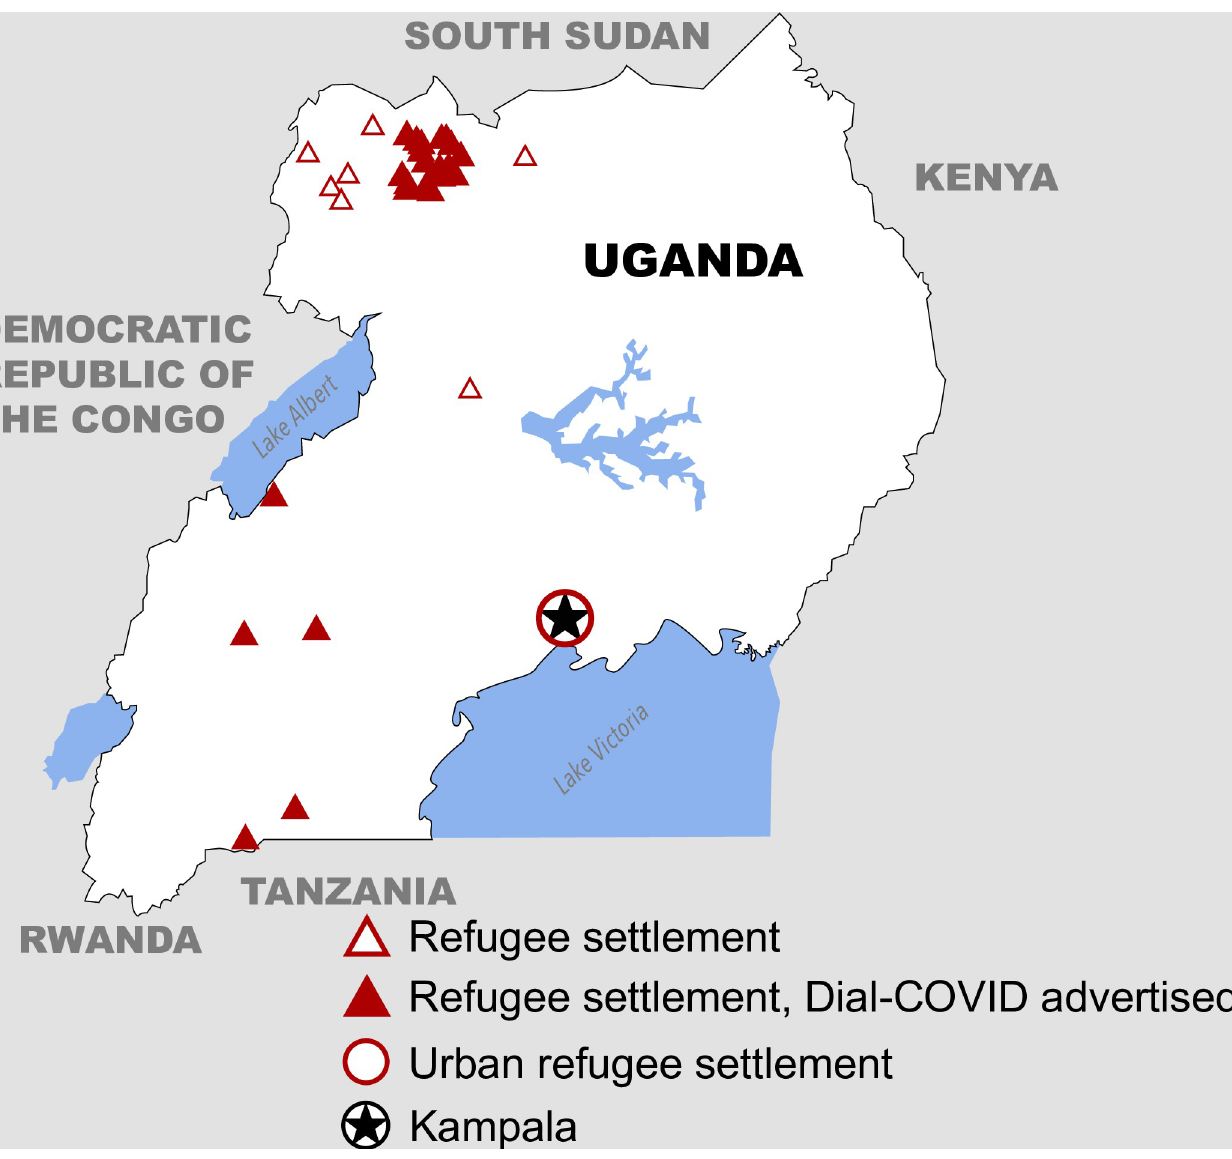
Fig 1. Map of refugee settlements in Uganda including Dial-COVID advertisement sites. Refugee settlements where Dial-COVID was advertised include Nakivale, Oruchinga, Rwamwanja, Kyaka II, Kyangwali, Oliji � , Maaji I � , Maaji II � , Maaji III � , Mungula � , Mungula II � , Ayilo I � , Ayilo II � , Alere 2 � , Boroli � , Olua I � , Olua II � , Pagrinya � , Nyumanzi � , Elema � , Baratuku � , Agojo � , Mirieyi � , and Palorinya. � Referred to collectively as Adjumani Refugee